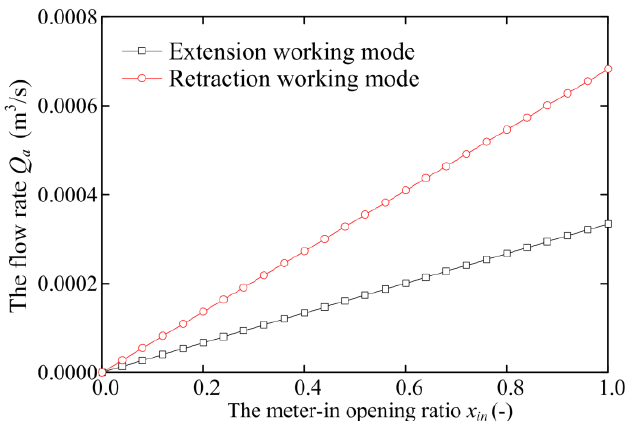
Figure 25. The variations of the flow rate Q a of the cylinder head chamber of HPCIMS.